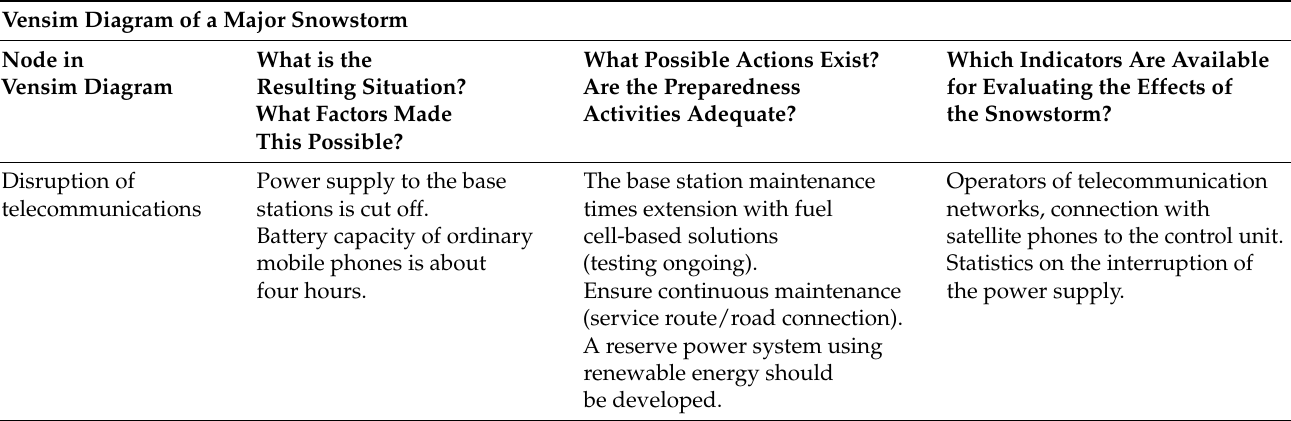
Table 2. Summary of results of the